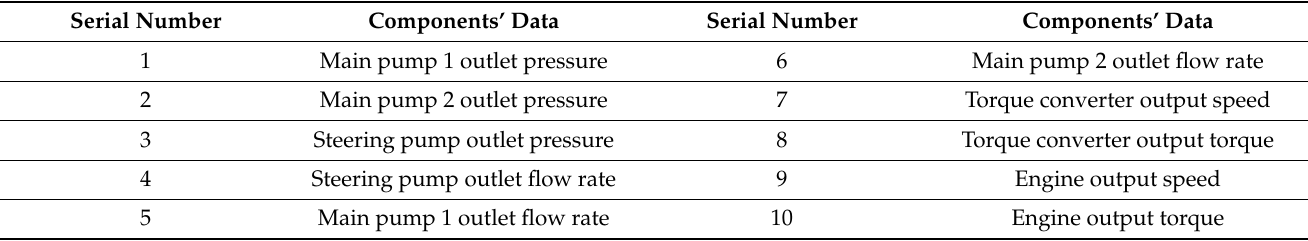
Table 2. Data collection under transportation condition.